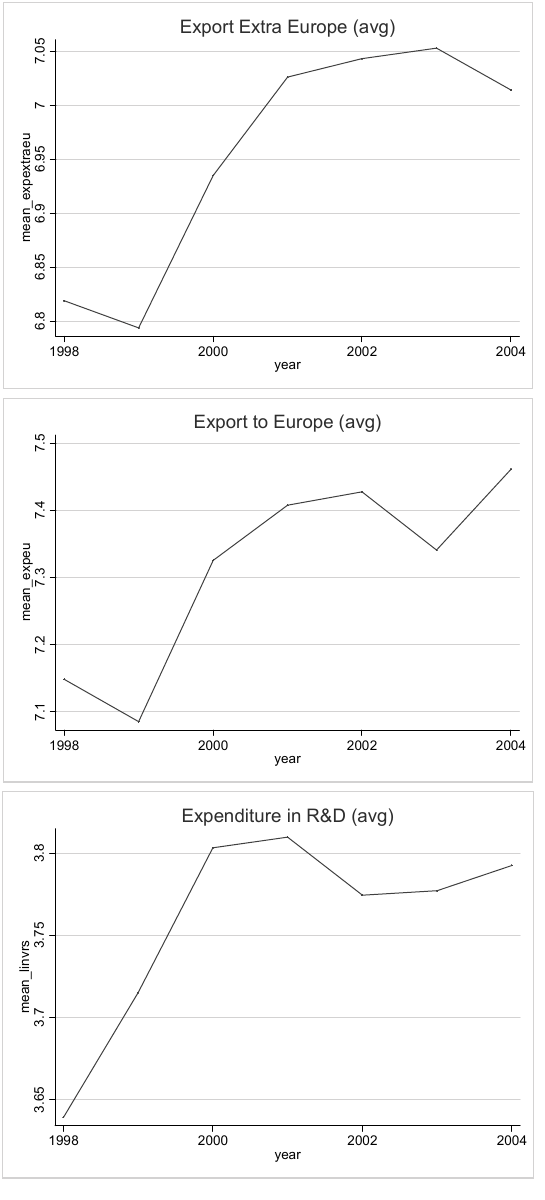
Figure 2 – Time Series of selected variables (different